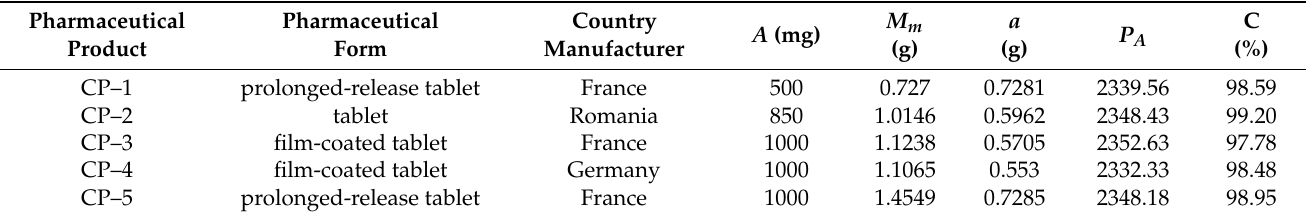
Table 10. Experimental data obtained from the study of the M-HCl content of